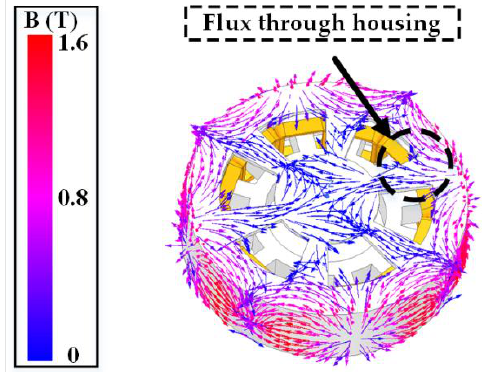
Figure 3. Magnetic flux density through the housing part.